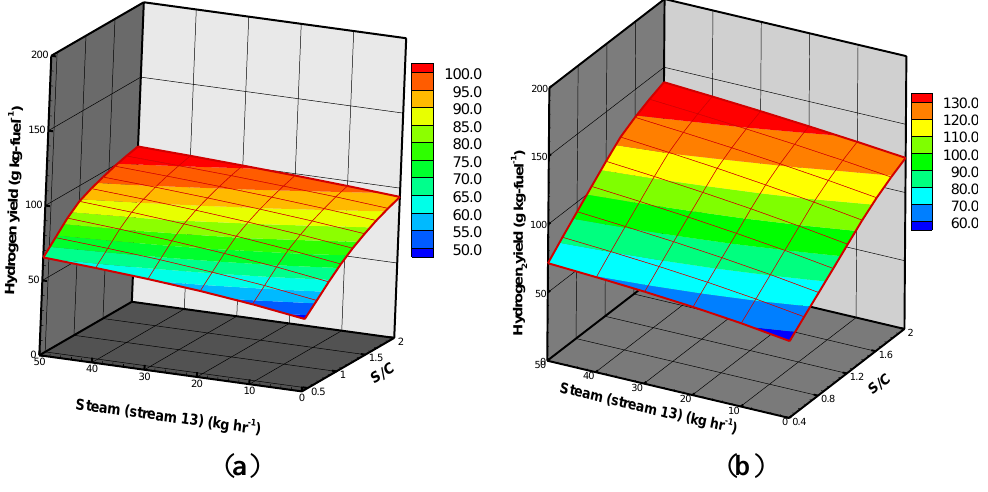
Figure 7. Three-dimensional distributions of hydrogen yield from the gasification of ( a ) ROP; and ( b )